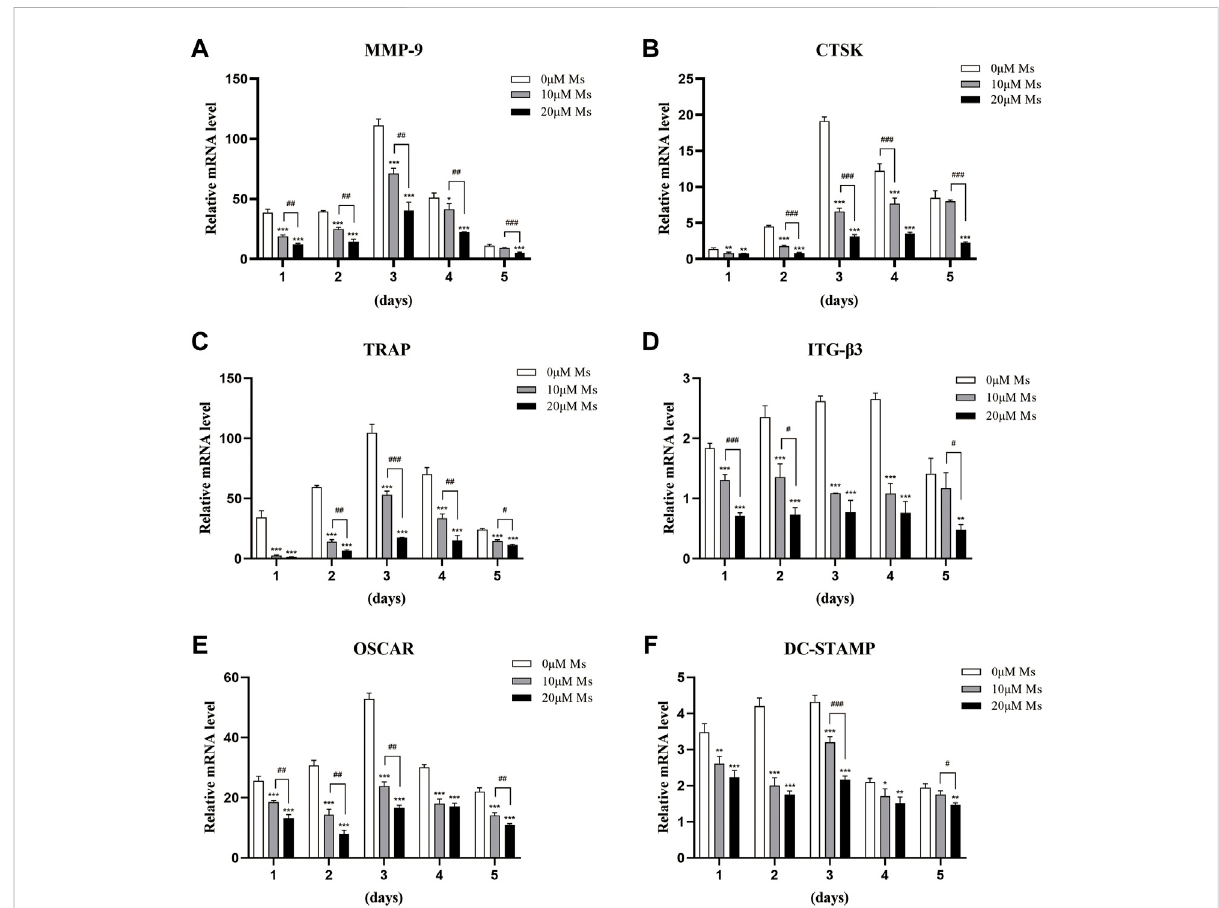
Ms inhibitstheRANKL-induced expression ofosteoclastic markergenes. RAW264.7 cells were treated with or without Ms (10and 20 μ M) inthe presence of RANKL (50 ng/ml) after a 1 – 5 days culture period. The mRNA expression levels of osteoclast-speci fi c genes, such as MMP-9 (A) ,